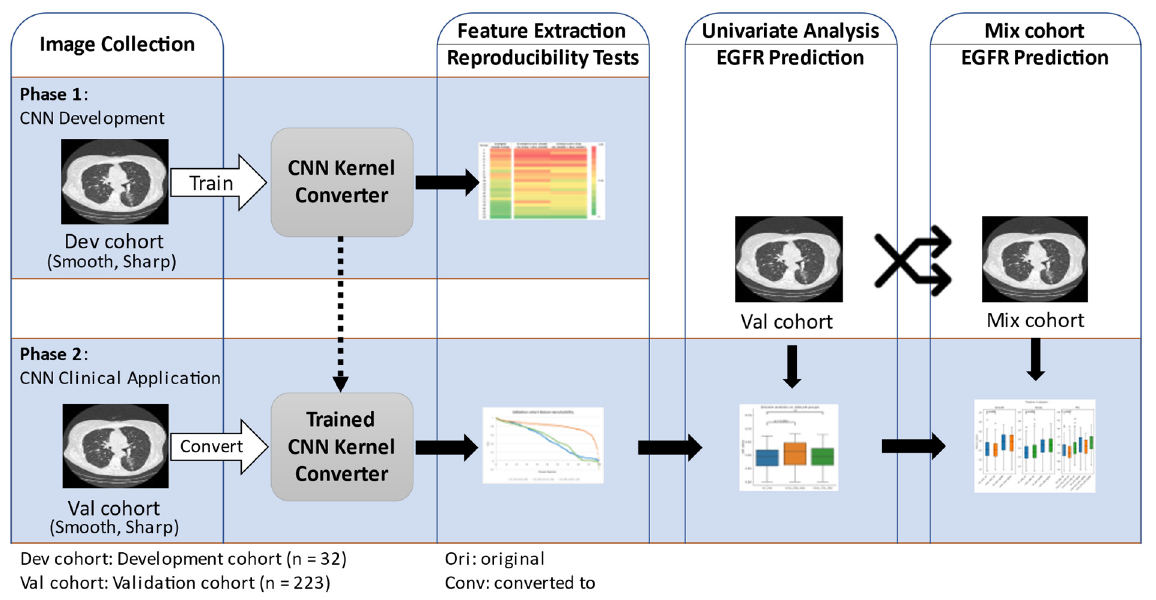
Figure 1. Study diagram. The diagram summarizes the two phases of our study.